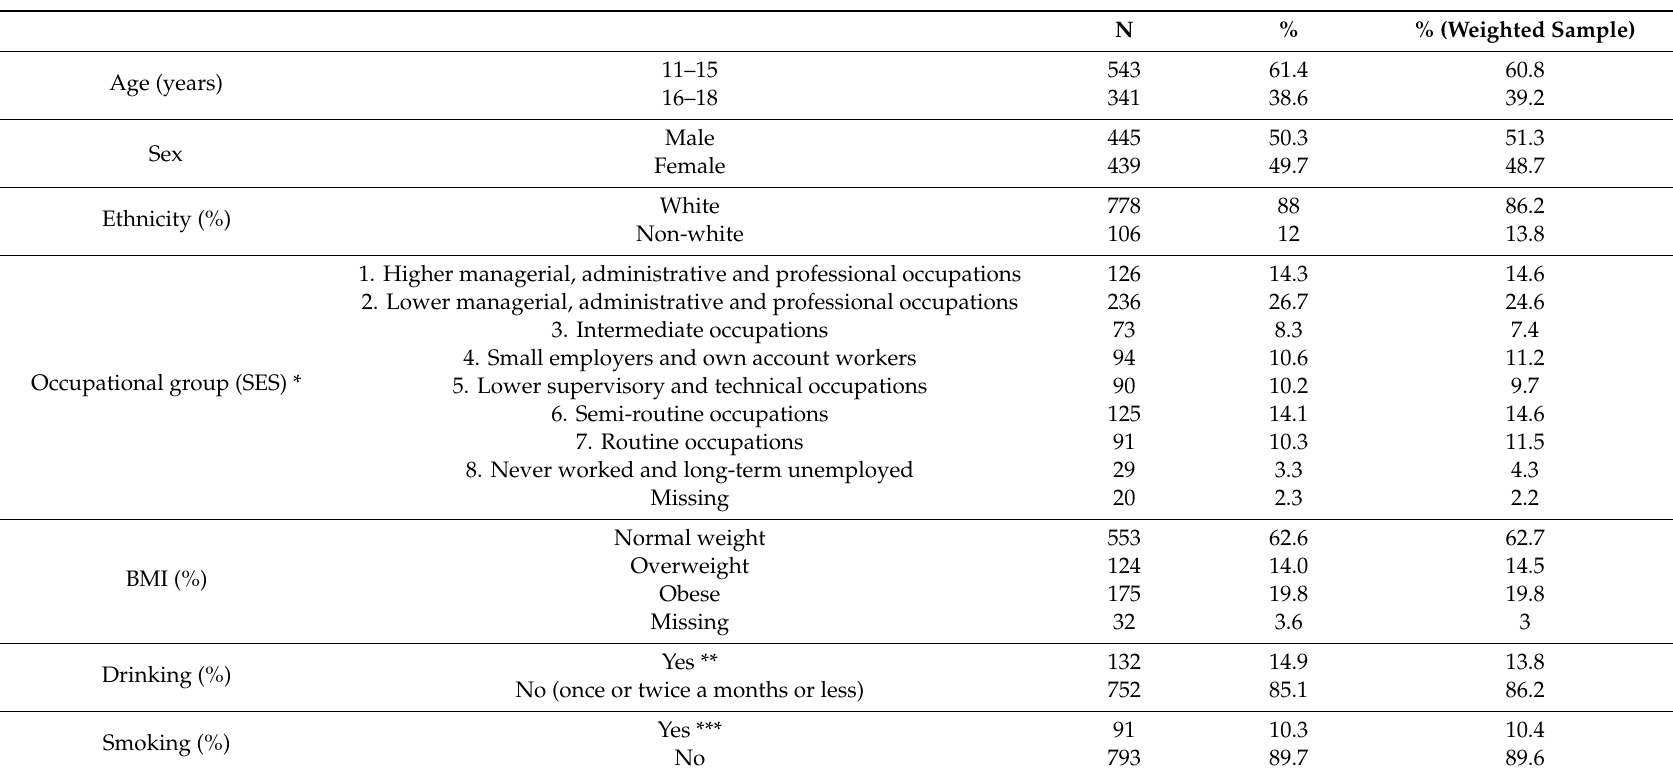
Table 2. Participant characteristics. Data are from the National Diet and Nutrition Survey Rolling Programme Years 1–4 (2008–2012) for all respondents aged 11 to 18 years